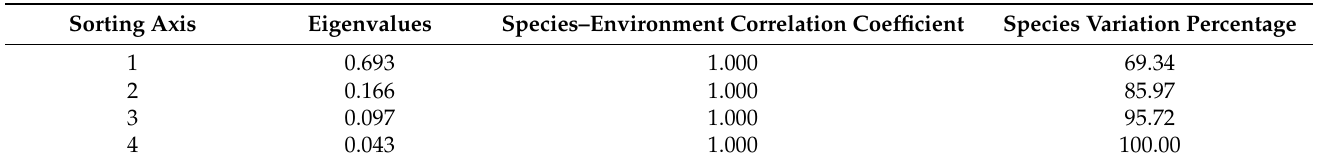
Table 5. Redundancy analysis of zooplankton biomass and environmental factors in Lake Chen Yao and Lake Feng Sha.